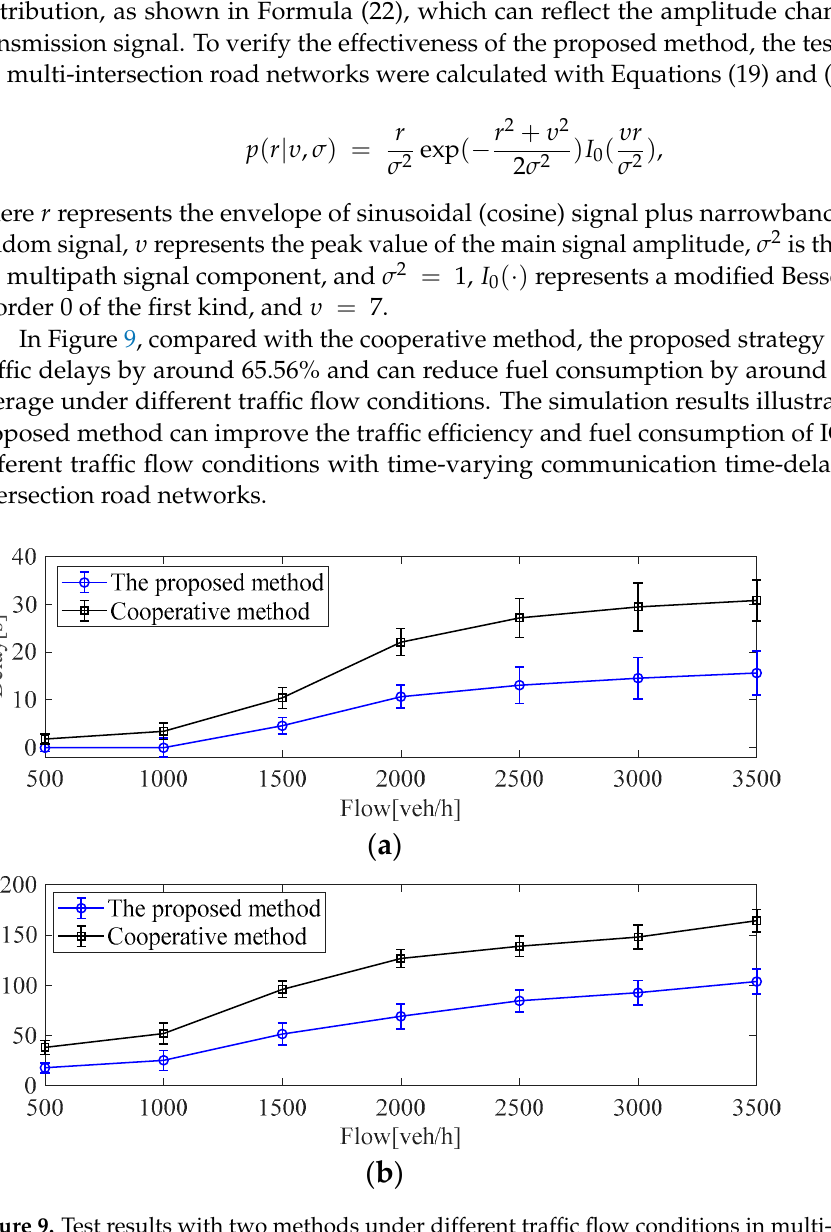
Figure 9. Test results with two methods under different traffic flow conditions in multi-intersection road networks: ( a ) comparison results of traffic delay; ( b ) comparison results of fuel consumption.